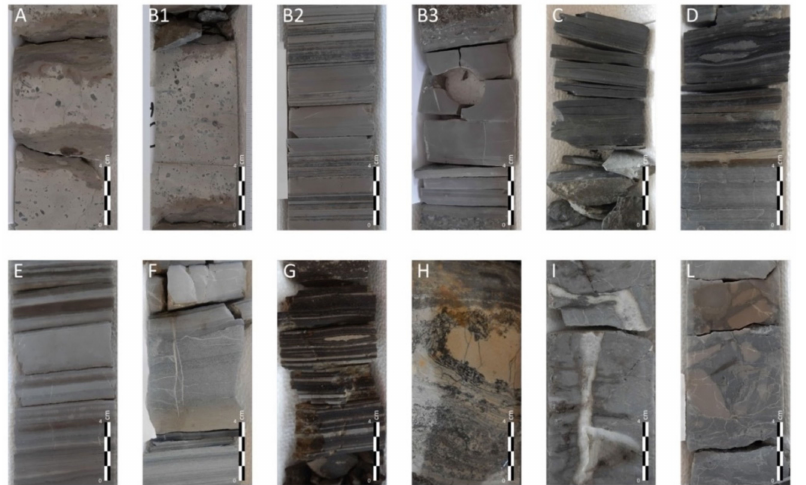
Figure 4. Core photos of representative facies from the Eureka 1 well (capital letters are referred to the facies described in the text and summarized in Table 1). ( A ) beige claystones; ( B1 ) Light gray bioclastic limestone; ( B2 ) Light gray microbialite; ( B3 ) Light gray limestone; ( C ) Dark gray/black shale; ( D ) Brown microbialite; ( E ) Brown algal mats; ( F ) Brown carbonate; ( G ) Brown algal mats; ( H ) Brown algal mats; ( I ) Gray limestone; ( L ) Light gray/light brown carbonate breccia. Table 1. Facies description and depositional environment/process interpretation of Streppenosa and Noto Fms. sampled from the Eureka 1